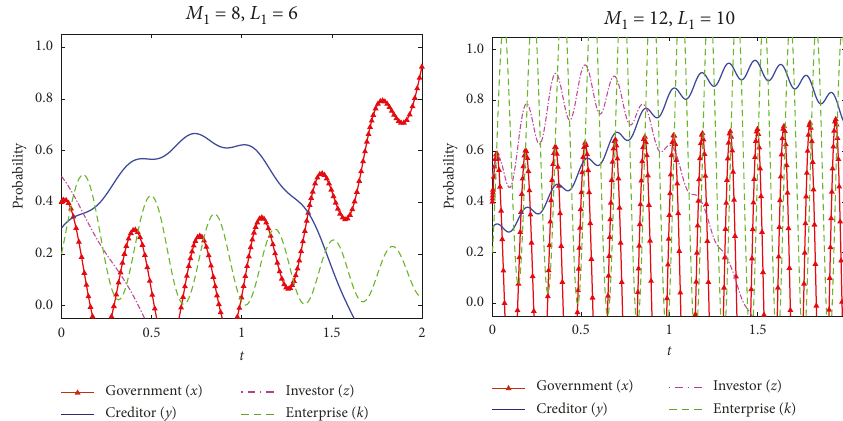
Figure 6: The influence of government support and binding force on system